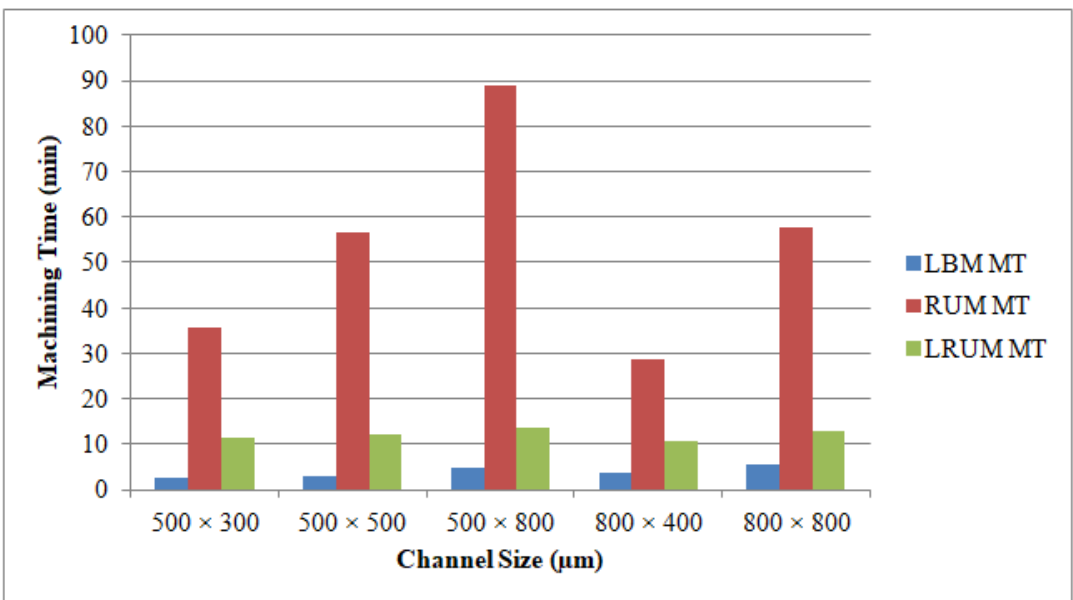
Figure 15. Results of the machining time (MT) of the fabricated channels by using LBM, RUM, and combined LRUM processes.